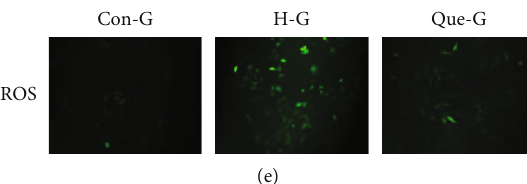
Figure 2: Quercetin ameliorates high-glucose-induced cardiomyocyte injury. (a) CCK-8 revealed changes in cell viability after coincubating H9C2 cells with di ff erent concentrations of quercetin for 24h. (b) Expression levels of pyroptosis-related proteins detected by WB. Data are expressed as the mean ± SD , ∗∗ P < 0 : 001 , H-G vs. Con-G, and Que-G. (c) The expression level of NLRP3 in cardiomyocytes from each group detected by immuno fl uorescence ( 200 × magni fi cation). (d) Fluorescence detection of mitochondrial membrane potential. The brighter the red fl uorescence, the stronger the mitochondrial membrane potential; the opposite condition stands for green fl uorescence ( 200 × magni fi cation). (e) A ROS fl uorescent probe was used to detect the accumulation of ROS in cardiomyocytes in each group ( 200 × magni fi cation). CON-G: glucose concentration of 5.5mmol/L; H-G: glucose concentration of 30mmol/L; Que-G: glucose concentration of 30mmol/L+quercetin; ROS: reactive oxygen